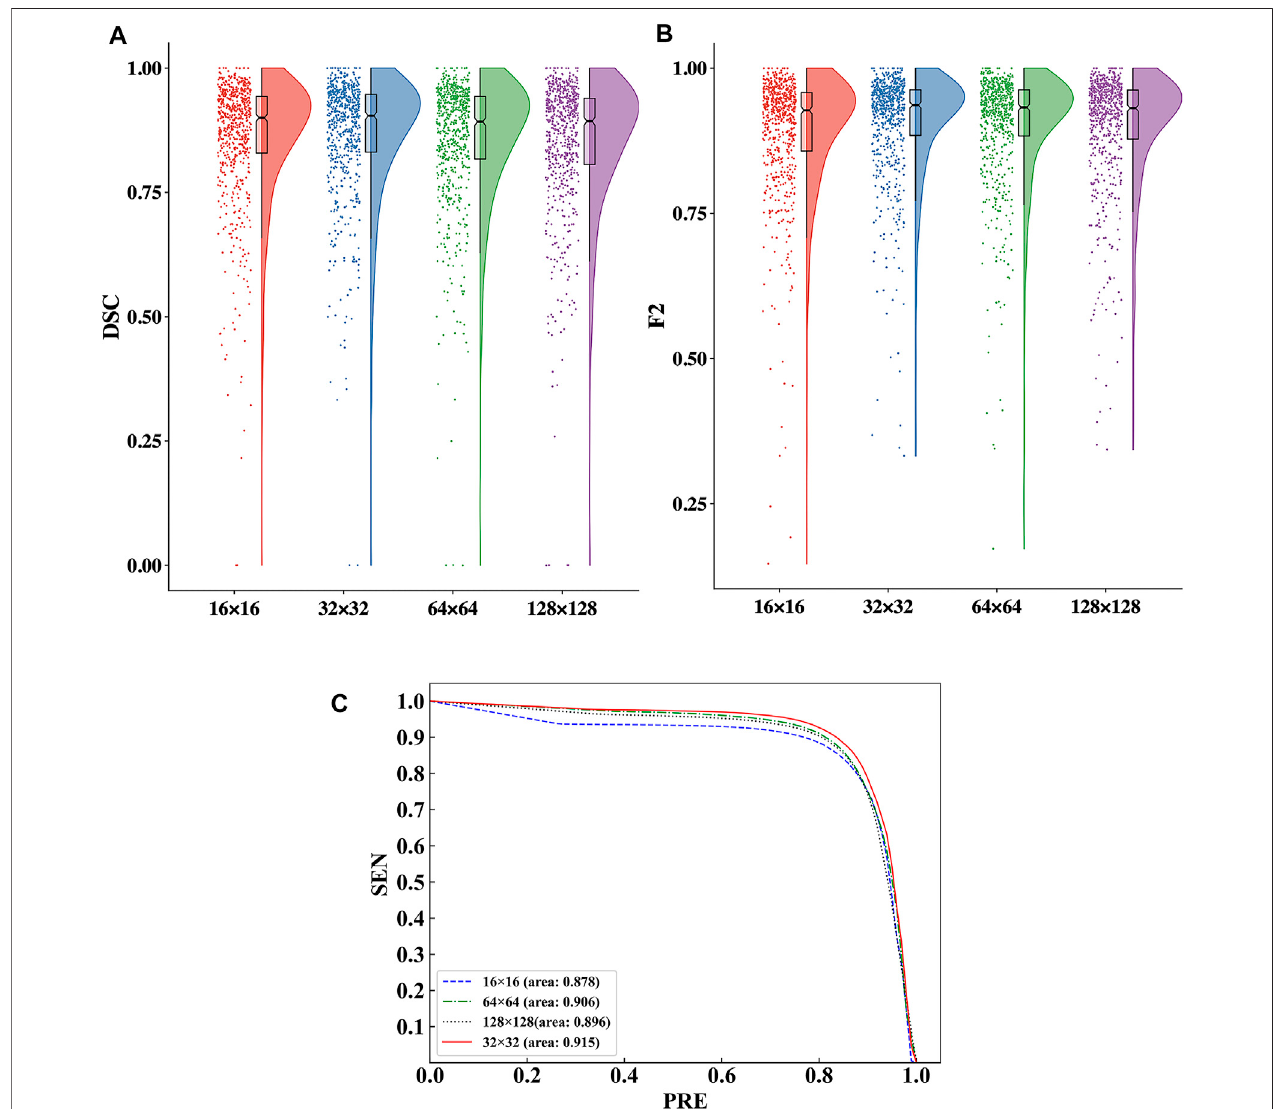
FIGURE 5 | Comparison ofthe segmentation performance for the four ROI sizes. (A) Comparison of the DSC values in the raincloud plot for the four ROI sizes. (B) Comparison of the F2 values in the raincloud plot for the four ROI sizes. (C) Comparison of the P-R curves of the segmentation performance for the four ROI sizes.